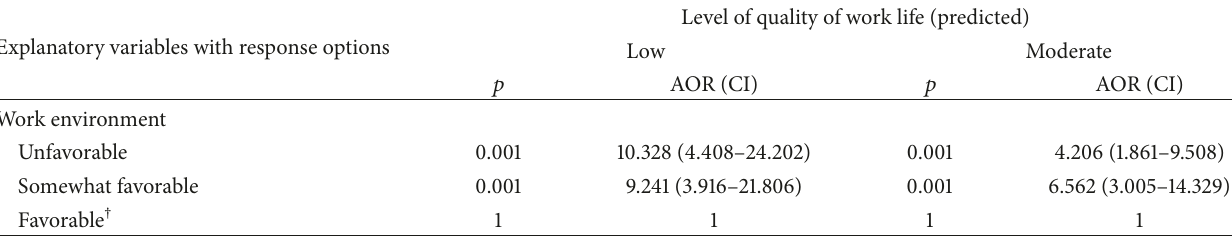
Table 4: Work environment and quality of work life among nurses working in public health facilities of Hawassa town, March 10–27, 2016 ( 𝑛 = 253